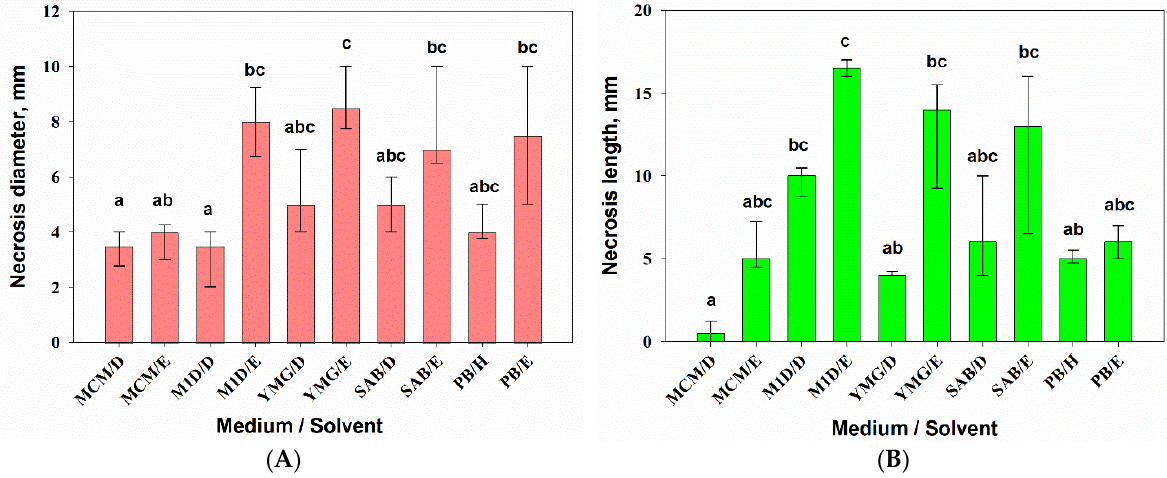
Figure 3. Phytotoxic activity of 0.5% extracts from Alternaria tenuissima MFP253011 cultures grown on various liquid and solid media 48 h post-treatment assayed on leaf discs of Sonchus arvensis ( A ) and leaf segments of Triticum aestivum ( B ). Median values with 25 ‒ 75% quartiles marked with the same letter did not differ significantly at the level of p = 0.05 according to Dunn’s test. D—dichloromethane, E—ethyl acetate, H—hexane.